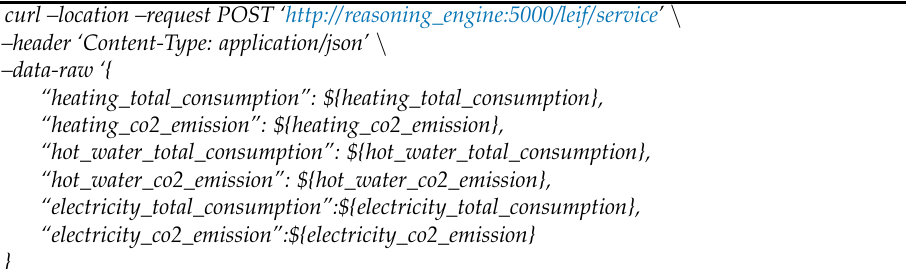
Figure 2. Reasoning Engine proposed architecture. Table 1. Reasoning Engine’s REST API collection